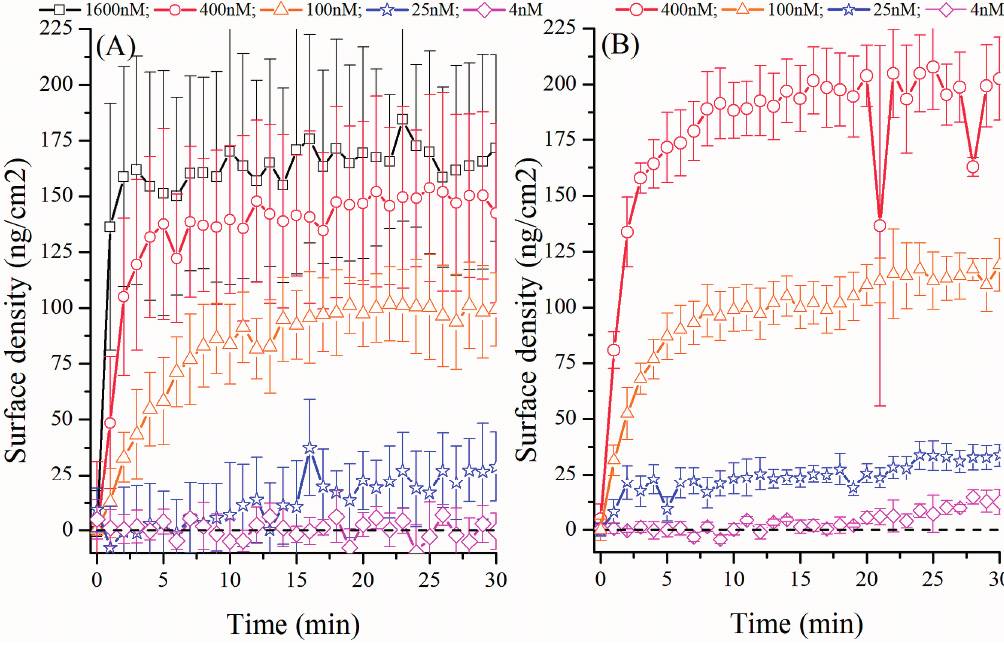
Figure 4. Binding kinetic for neutravidin on a Ø = 20 µm biotin functionalized sphere with sphere operated ( A ) below and ( B ) above the lasing